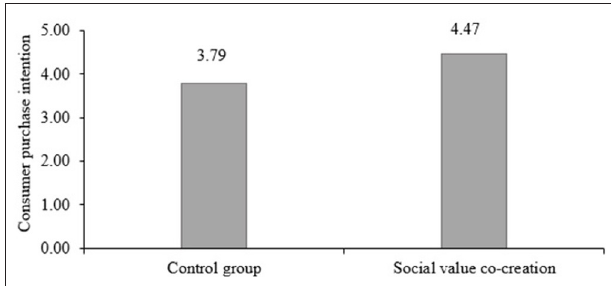
FIGURE 1 | The effect of social value co-creation (vs. control group) on consumer purchase